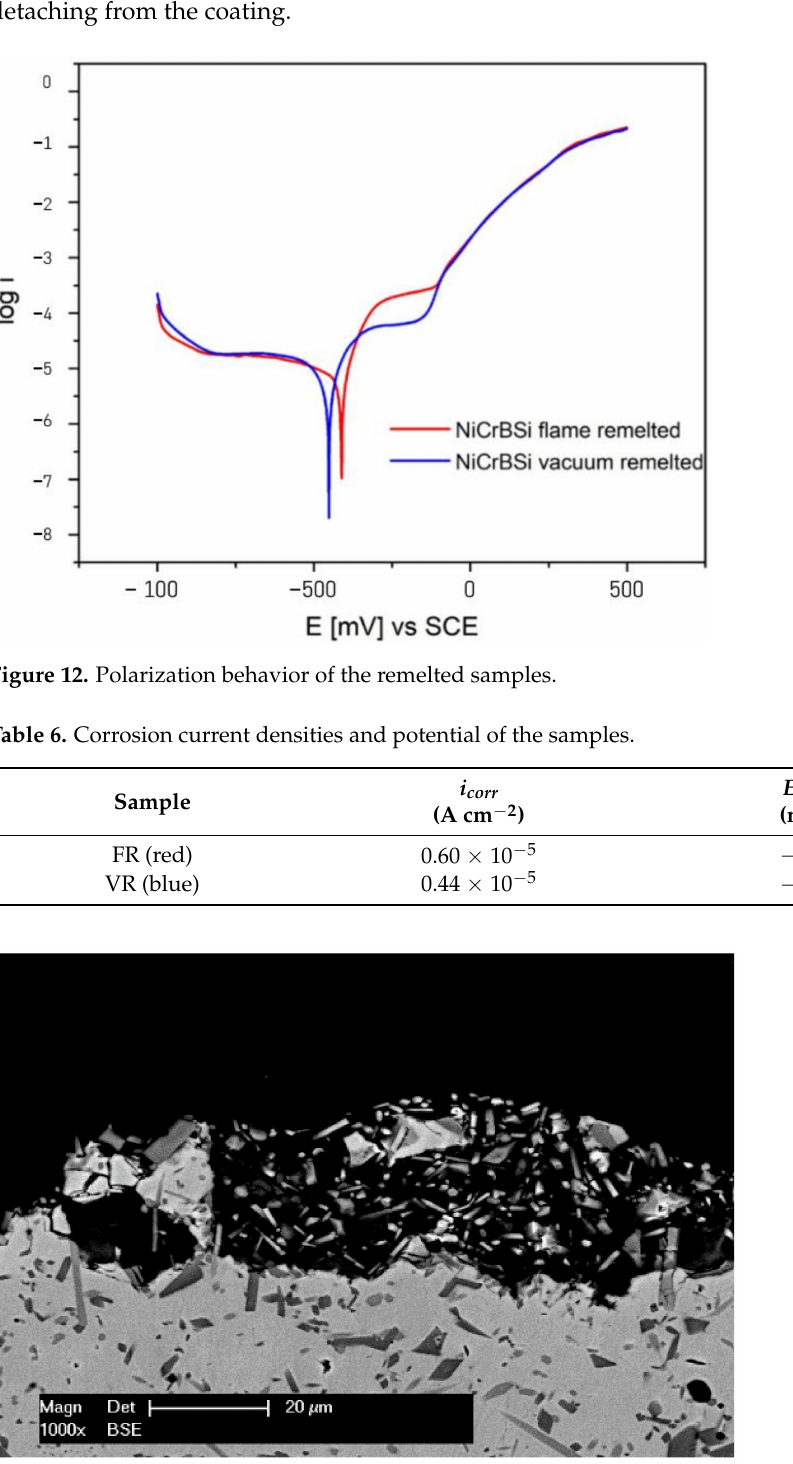
Figure 13. BSE micrograph of the VR corroded